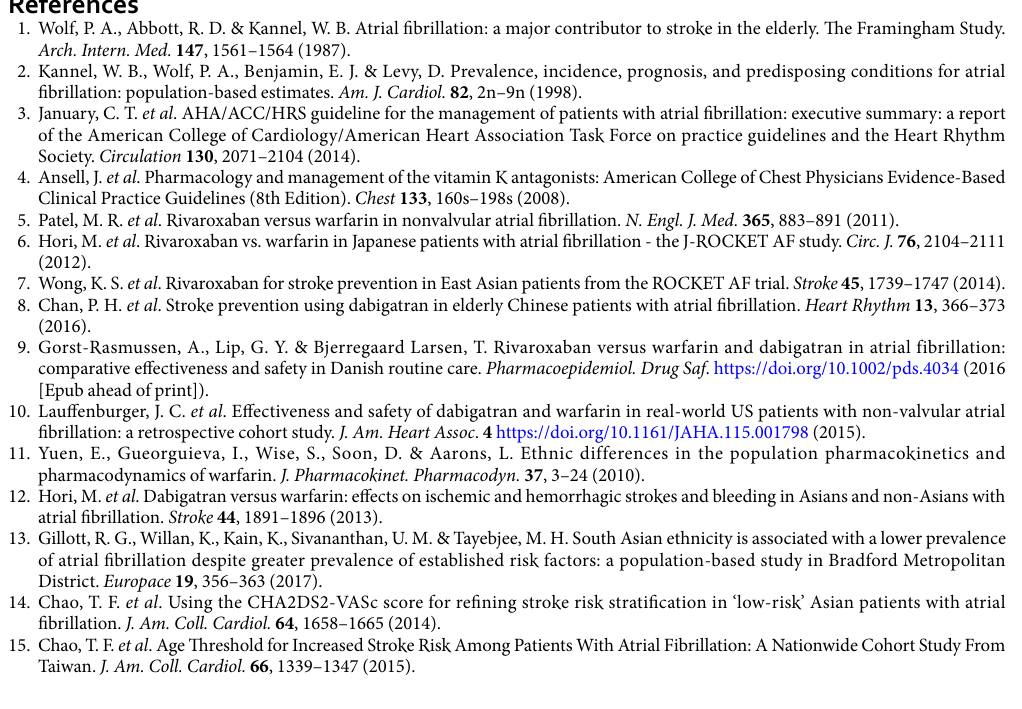
8 SCIeNTIfIC RepoRts | (2018) 8:3451 | DOI:10.1038/s41598-018-21884-y